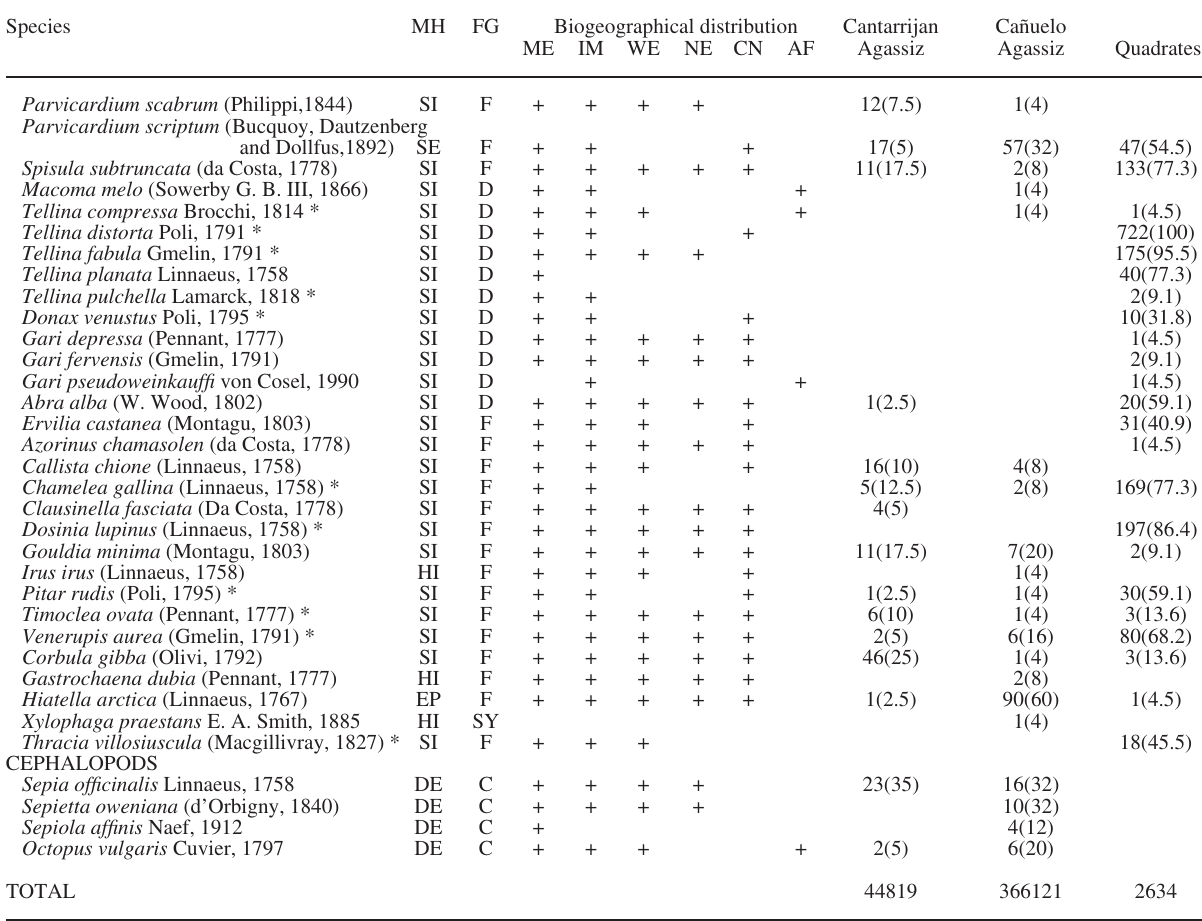
Table 2 (cont.). – faunistic list of molluscs found in Zostera marina beds in southern spain, with quantitative data from arroyo et al. (2006) (Cantarriján, agassiz), Rueda et al. (2008b) (Cañuelo, agassiz) and Rueda and salas (2008) (Cañuelo, quadrates).